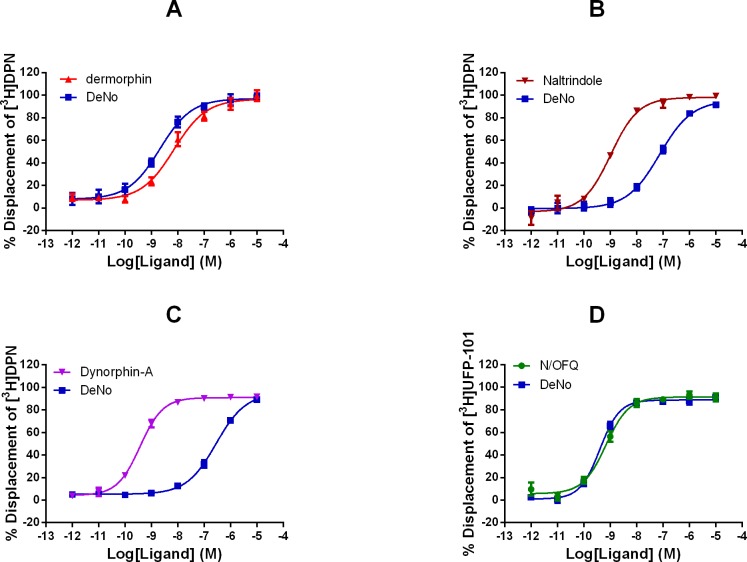
Displacement Binding.Displacement of tritiated Diprenorphine ([3H]-DPN) by dermorphin, DeNo, and reference ligands at (A) CHOhMu, (B) CHOhDelta, (C) CHOhKappa and the displacement of tritiated UFP-101 ([3H]-UFP-101) by DeNo and N/OFQ at (D) CHONOP cell membranes. Data are means (SEM) of n≥5 experiments for all cell lines. Reference ligands: dermorphin; naltrindole; dynorphin-A; N/OFQ, (nociception/orphanin FQ).